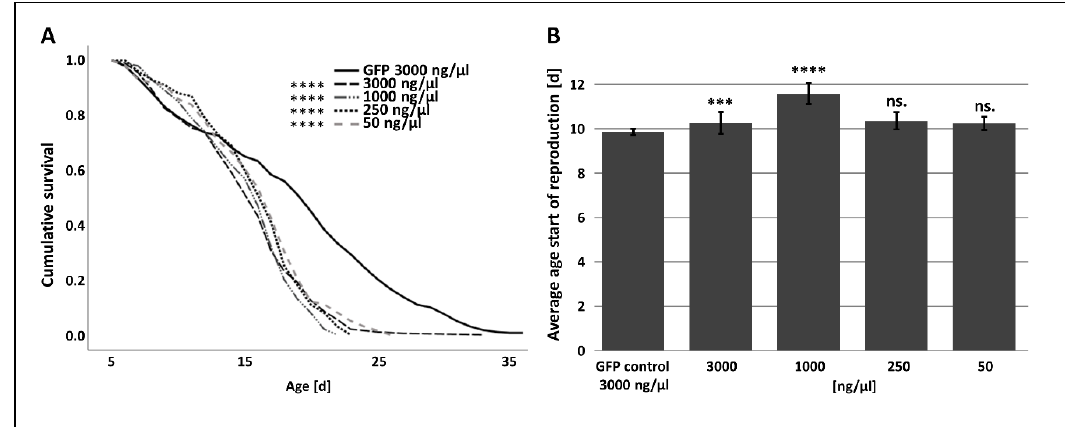
Figure 3. Life-history parameters following the injection of p300/CBP dsRNA in A. pisum . ( A ) Survival